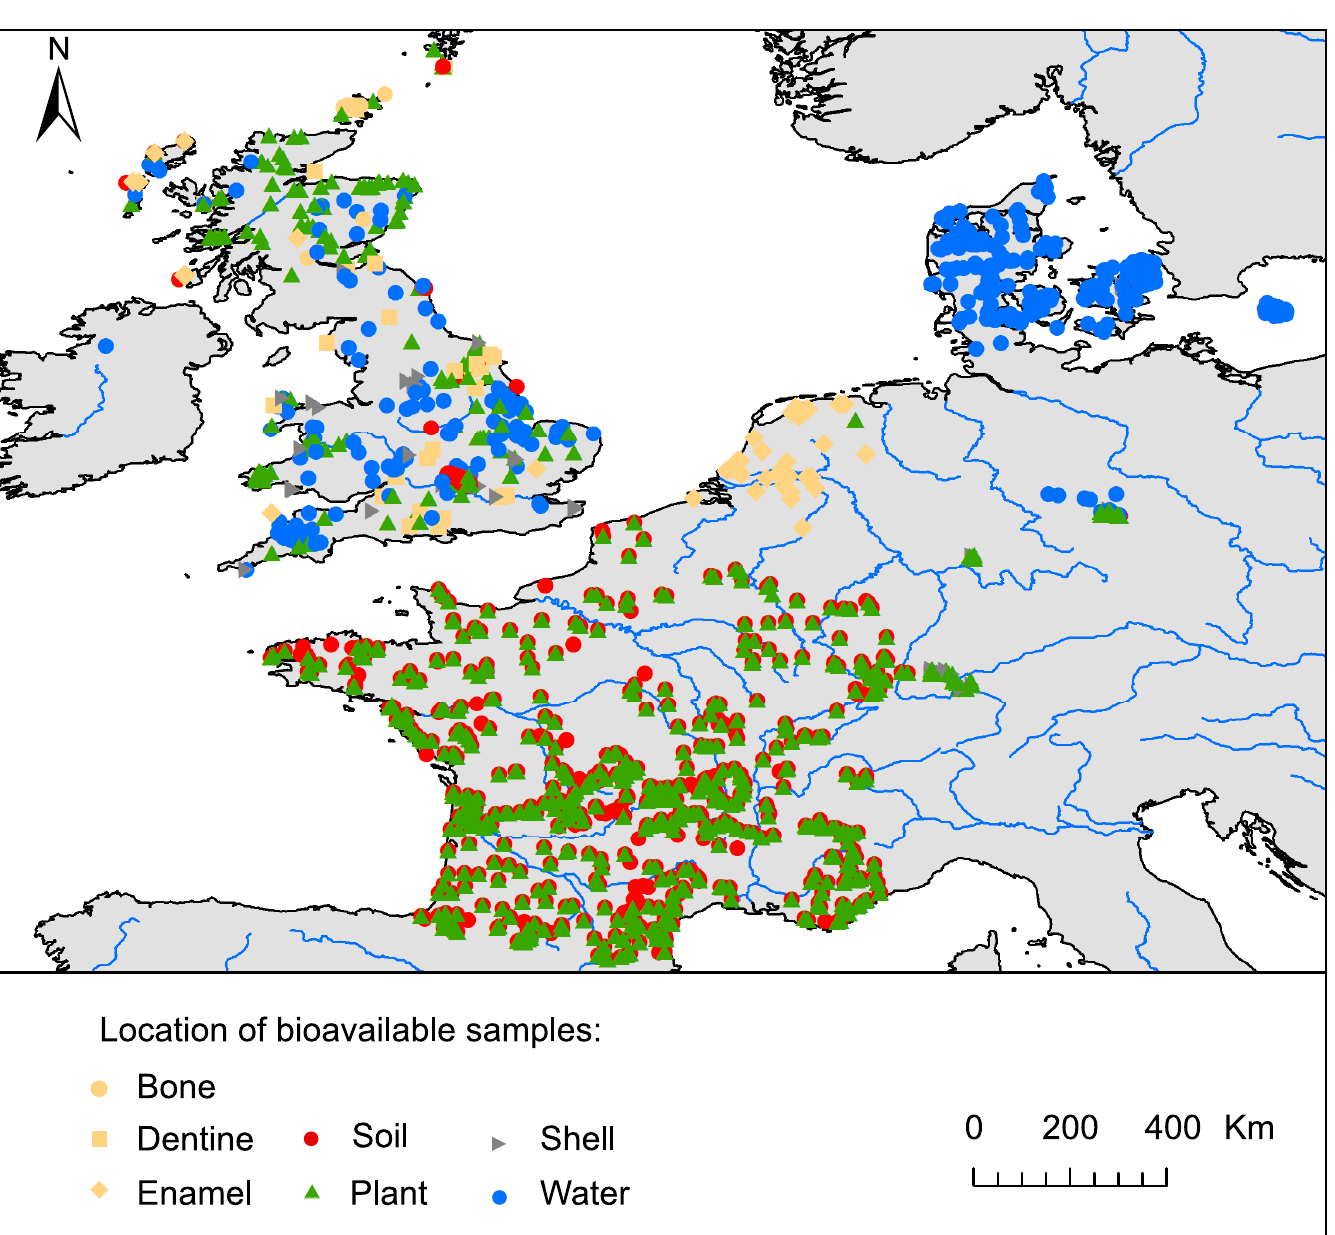
Fig 1. Sample locations and types of data included in the compilation dataset. Coastlines and rivers are from http://www.naturalearthdata.com/.